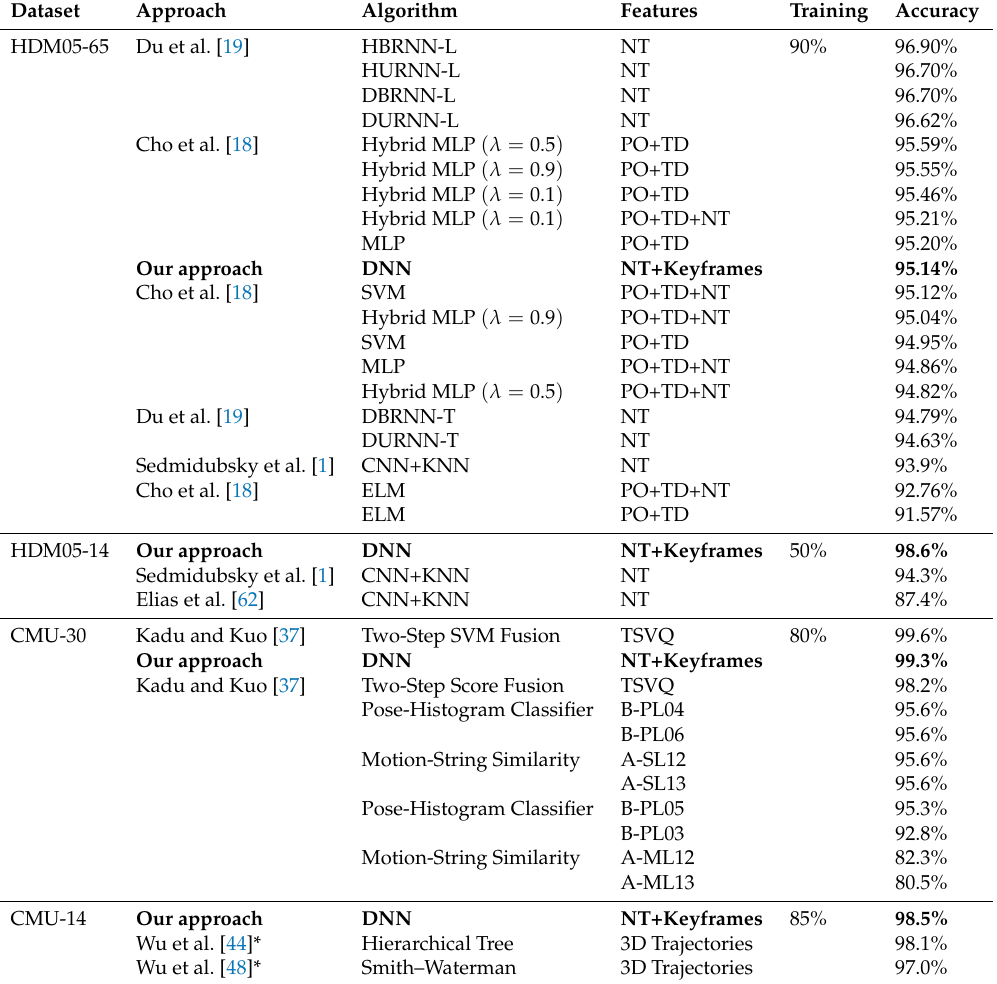
Table 3. Comparison with other state-of-the-art methods on the datasets HDM05-65, HDM05-14, CMU-30, and CMU-14. The results are presented in top-down order. The results using our approach are shown in bold text. * The CMU dataset with 14 classes was used, as well as the dataset recorded with their own Vicon (http://www.vicon.com/) motion capture device. Note: Normalized Trajectories (NT), relative positions of joints (PO), Temporal Differences (TD), Tree Structure Vector Quantized (TSVQ), Hierarchically Bidirectional Recurrent Neural Network with Long-Short Term Memory (LSTM) (HBRNN-L). For more details, see Sections 2 and